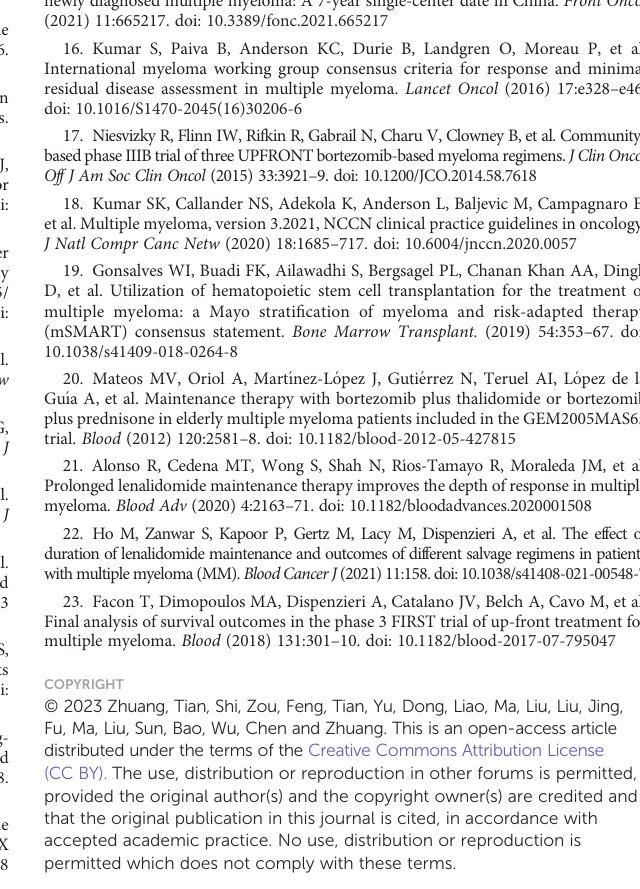
The median PFS and median OS of patients with 1q21 ampli fi cation (n=30) versus those without (n=78) in patients on thalidomide maintenance. SUPPLEMENTARY FIGURE 3 Impact of 17p deletion on progression-free survival (PFS) and overall survival (OS) of lenalidomide, bortezomib and thalidomide maintenance. (A, B) The median PFS and median OS of patients with 17p deletion (n=16) versus those without (n=78) in patients on lenalidomide maintenance. (C, D) The median PFS and median OS of patients with 17p deletion (n=11) versus those without (n=55) in patients on bortezomib maintenance. E, F The median PFS and